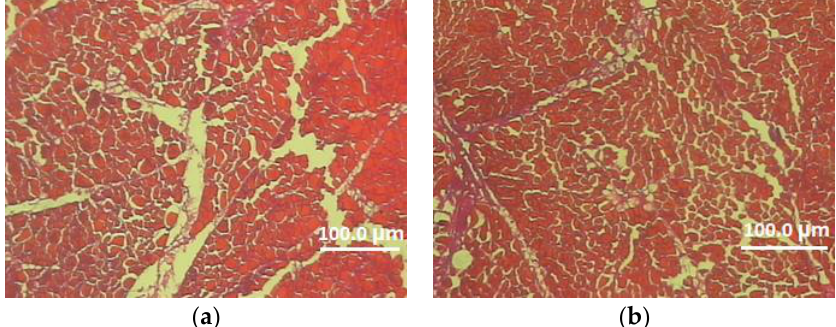
Figure 1. Cross-section of the superficial pectoral muscle of male ( a ) and female ( b ) 113-week-old Pekin P-9 strain (magnification 100×).